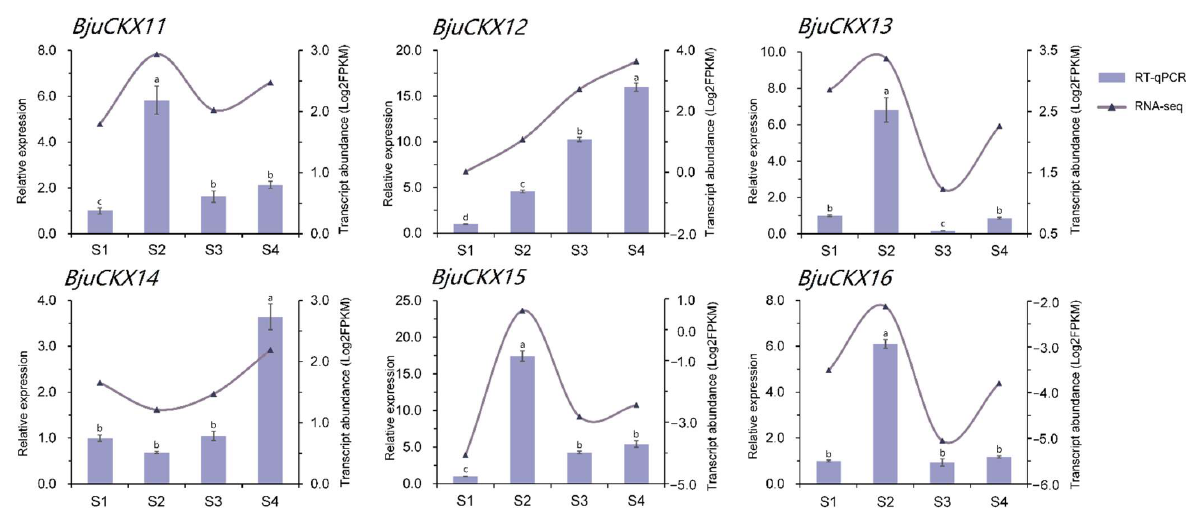
Figure 8. Relative expression of CKX genes at different developmental stages in B. juncea var. tumida . The column represents the RT-qPCR expression and the curve represents the RNA-seq. Each bar represents the mean ± SD, T-test at the significance level of 0.05 ( p < 0.05), different letters (a, b, c) indicate significant difference, and the same letters indicate insignificant differences.